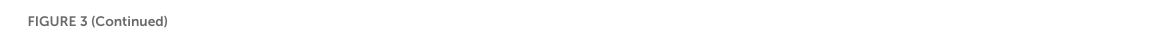
FIGURE3(Continued) showing contribution of top 10 fiber morphologies to PC1 (B) and PC2 (C) from PCA. Dashed red line corresponds to expected value if contribution were uniform indicating morphologies exceeding this value are important contributors to PCs. (D) Dendrogram from HCPC shows 3 clusters of tumors based on similarity in fibrillary morphologies (gray = cluster 1, yellow = cluster 2, blue = cluster 3). Heatmaps reporting TIL counts, Tumor killing, TLS maturation stage, body site, and ECM components for each tumor distributed across fibrillary clusters. (E) Vector weights for individual morphologies contributing to separation of samples along PC1 and PC2 (color indicates percent contribution). (F) Scatterplot using dimensions from PC1 and PC2 generated from PCA summarizing fibrillary matrix morphologies for individual tumors. TIL counts are indicated by color gradient (purple = high, yellow = low) and shape indicates fibrillary cluster assigned based on hierarchical clustering of PCs. (G) Boxplot displaying median TIL counts for individual tumors based on fibrillary cluster. Distribution of TIL counts were significantly higher in fibrillary cluster 1 compared to cluster 2 ( p- value < 0.0001) and higher in cluster 3 compared to cluster 2 ( p- value = 0.009), while no significant difference was reported between cluster 1 and 3; Two-tailed Mann-Whitney U. (H) Scatterplot using dimensions from PC1 and PC2 generated from PCA summarizing fibrillary matrix morphologies for tumors proximal to primary TLS. TIL counts are indicated by color and shape indicates fibrillary cluster. (I,J) Table (i) and boxplots (j) reporting fiber morphologies significantly associated with each fibrillary cluster resulting from HCPC. Square correlation coefficient and p- value of the F -test in a one-way analysis of variance is reported in the table